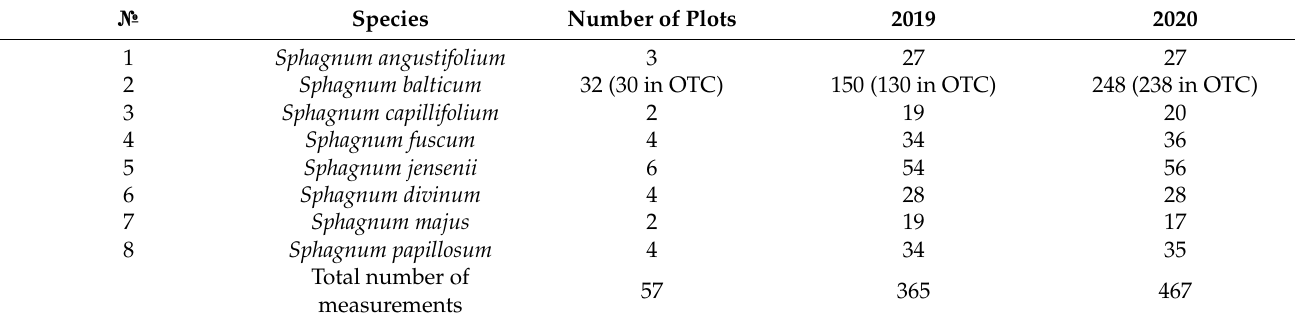
Table A2. Number of plots and total number of measurements made in 2019 and 2020 for monitoring of Sphagnum annual growth in Mukhrino field station.